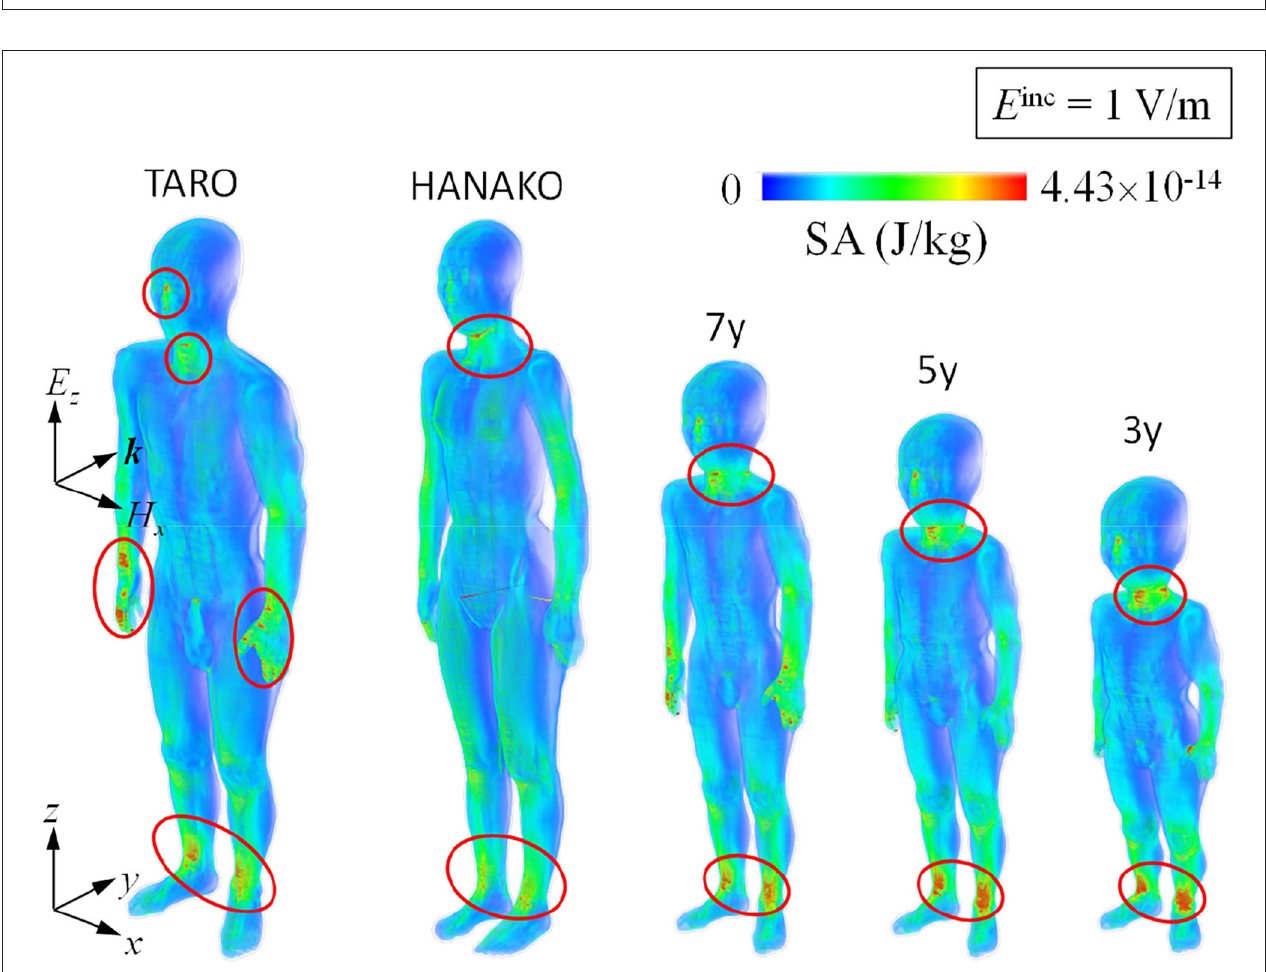
FIGURE 8 | SA distribution for one pulse illumination for various ungrounded human models.